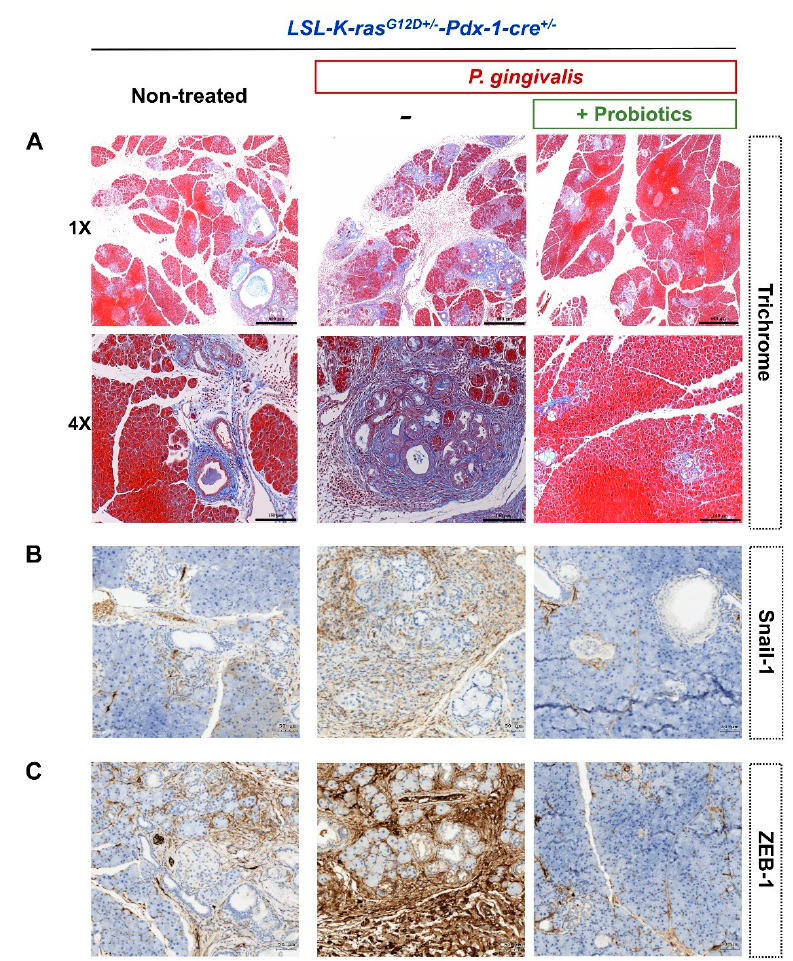
Figure 5. Representative images of pancreatic histology by various staining methods in non-treated KC mice, P. gingivalis -treated KC mice, and P. gingivalis plus probiotic-treated KC mice at four weeks after treatment (GMNL 89: GMNL133 in 1:1 ratio). ( A ) trichrome staining (upper scale bar, 400 µ m; lower scale bar, 150 µ m). ( B ) Snail-1 staining (scale bar, 50 µ m). ( C ) ZEB-1 staining (scale bar, 50 µ m). KC, LSL-K-ras G12D+/- -Pdx-1-cre +/- ; ZEB-1, Zinc finger E-box-binding homeobox 1.